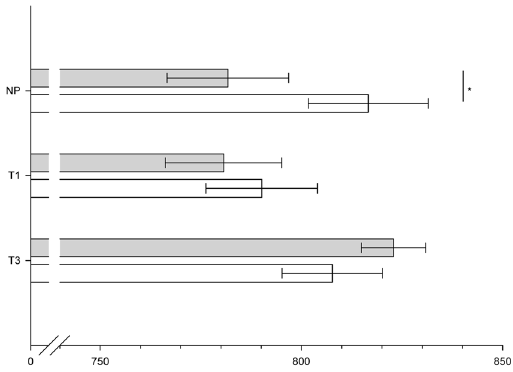
Figure 5. Mean ( ± SEM) P3-1 latencies (ms) in response to anxiety sweat (grey bars) and sport sweat (white bars) deviant stimuli of non-pregnant women (NP), pregnant women in the first (T1), and pregnant women in the third trimester (T3), * p < 0.05.